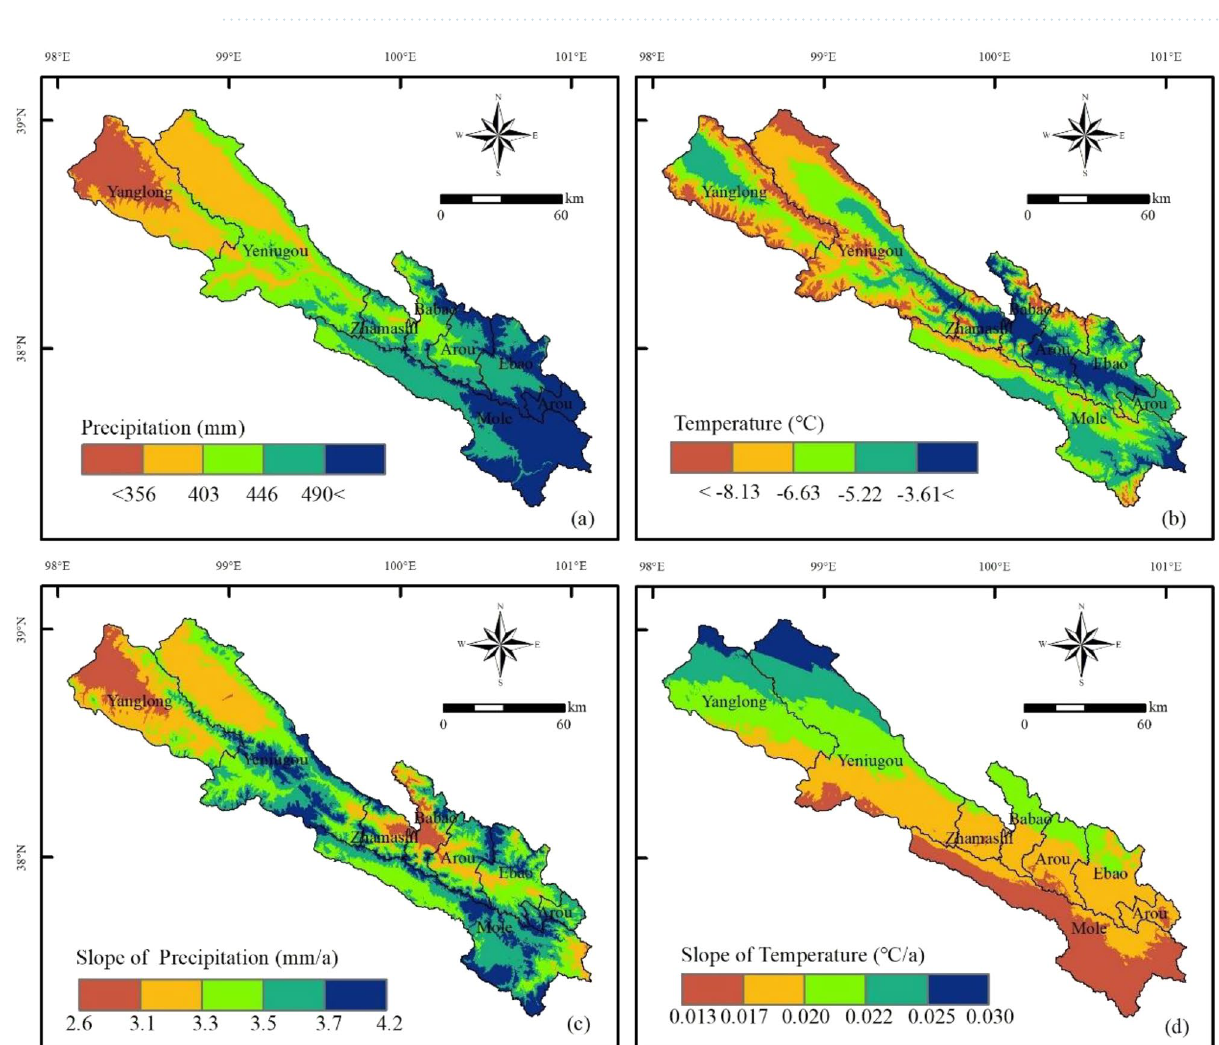
Figure 11. Spatial distribution ( a , b ) and variation (slopes) ( c , d ) in precipitation and temperature. The map was generated by ArcGIS 10.2, URL: https:// www. esri.